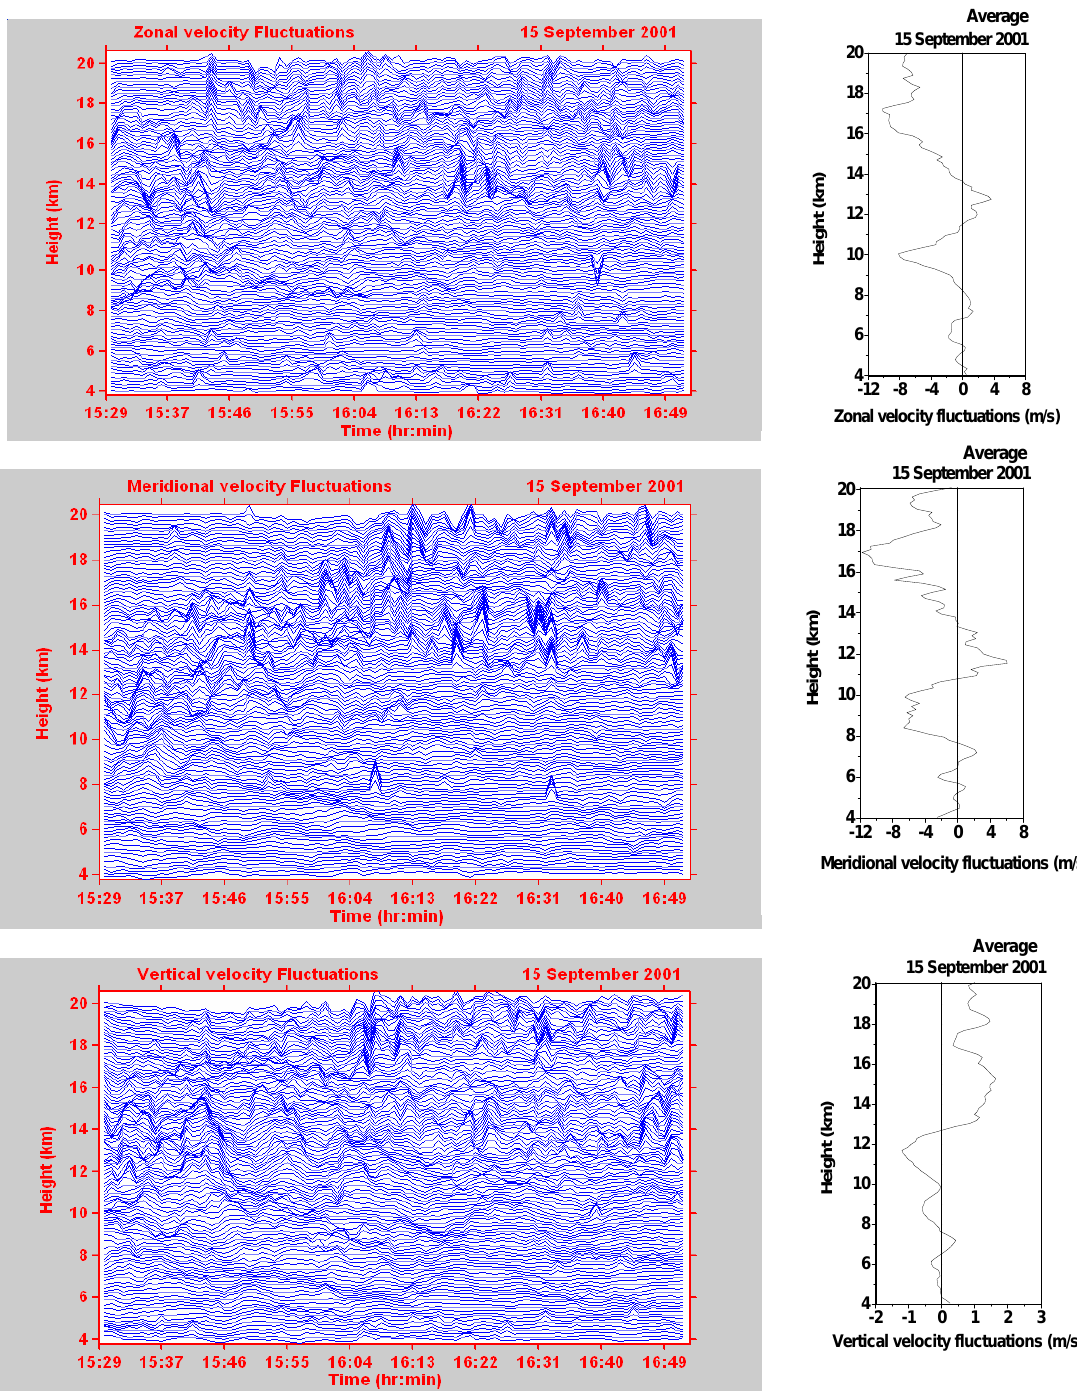
Fig. 6. Fig. 6. Height-time variation of zonal, meridional and vertical velocity fluctuations obtained by removing the background wind velocity at each height during the convection event on 15 September 2001 observed with Indian MST Radar. Successive profiles are displaced by 5m/s, 8m/s and 0.75m/s,